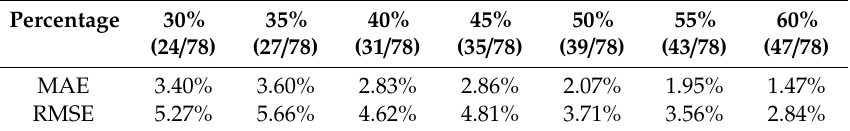
Table 4. Prognosis results for different percentages of target domain data.